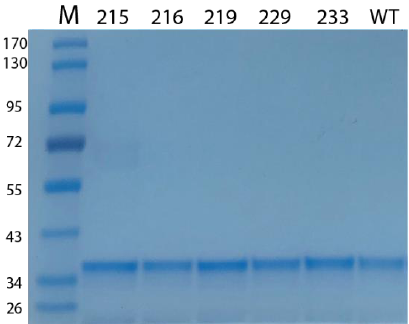
Figure 11. Purified recombinant proteins corresponding to the wild-type (WT) and mutated BAG-1 proteins. Approximately 1 μg of protein was loaded on an SDS-PAGE gel and stained with Coomassie blue stain M: molecular marker.